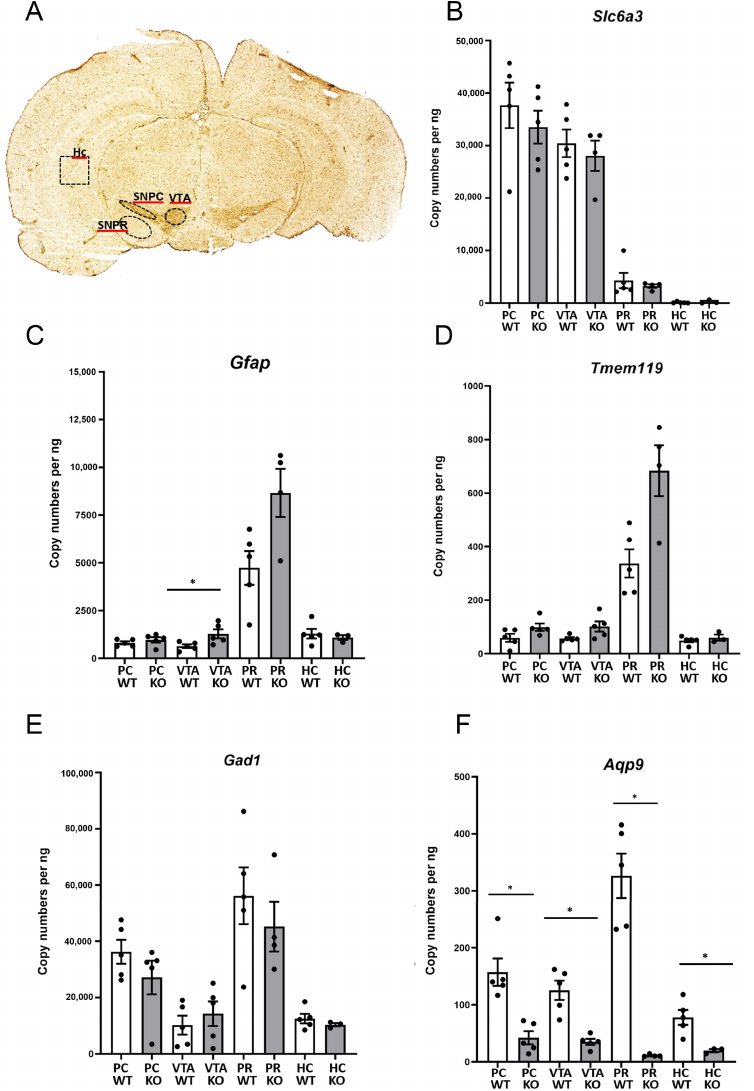
Figure 4. Regions selected for laser capture and expression of transcripts related to neuroinflam- mation in the dissected regions. ( A ) Overview of regions selected for laser capture on a scan of a section immunostained with an antibody to the dopaminergic cell marker tyrosine hydroxylase (TH). ( B ) Slc6a3 , the transcript for the dopamine transport DAT, is highly expressed in the pars compacta and VTA, with no significant difference between genotypes. ( C ) The astrocyte marker Gfap is